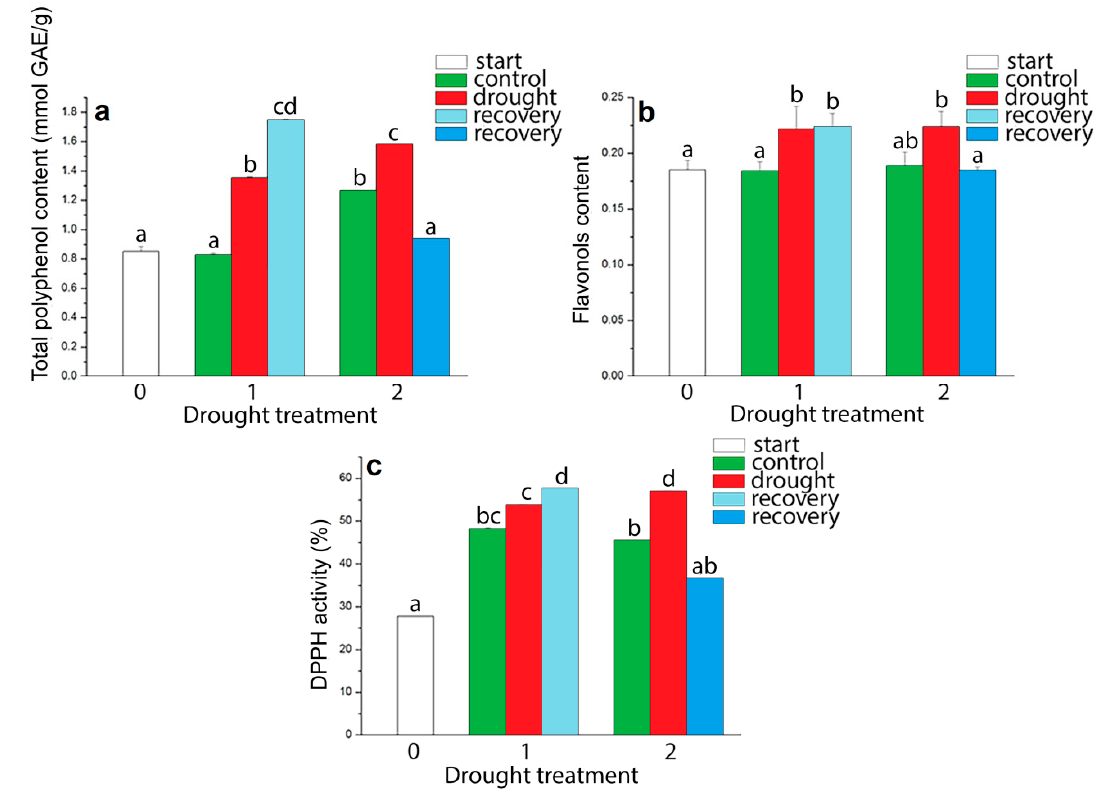
Figure 7. The effect of drought on total polyphenols ( a ) and flavonols ( b ) content, and 1,1 ′ -diphenyl-2-picrylhydrazyl (DPPH) activity ( c ) in I. walleriana grown ex vitro. The “start point”, 15% and 5% of soil moisture content—0, 1 and 2, respectively; results represent mean ± SE ( n = 8). The letters indicate statistically significant differences based on the Fischer LSD test ( p ≤ 0.05).